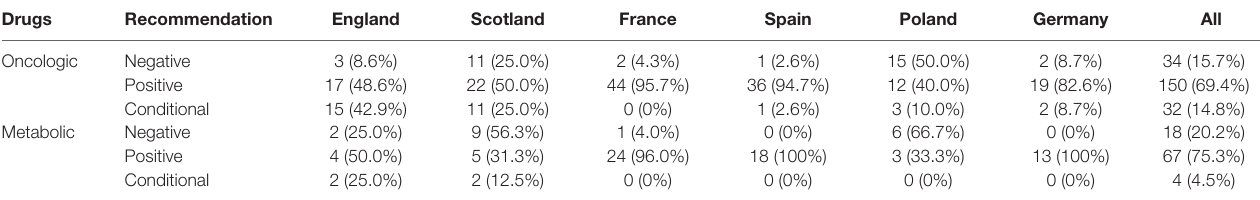
TABLE 1 | Recommendation for oncologic and metabolic drugs. Drugs